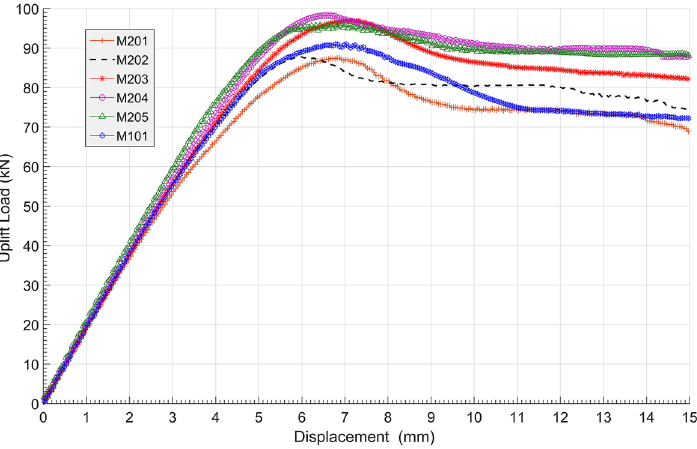
Figure 15. Load–displacement curves of group